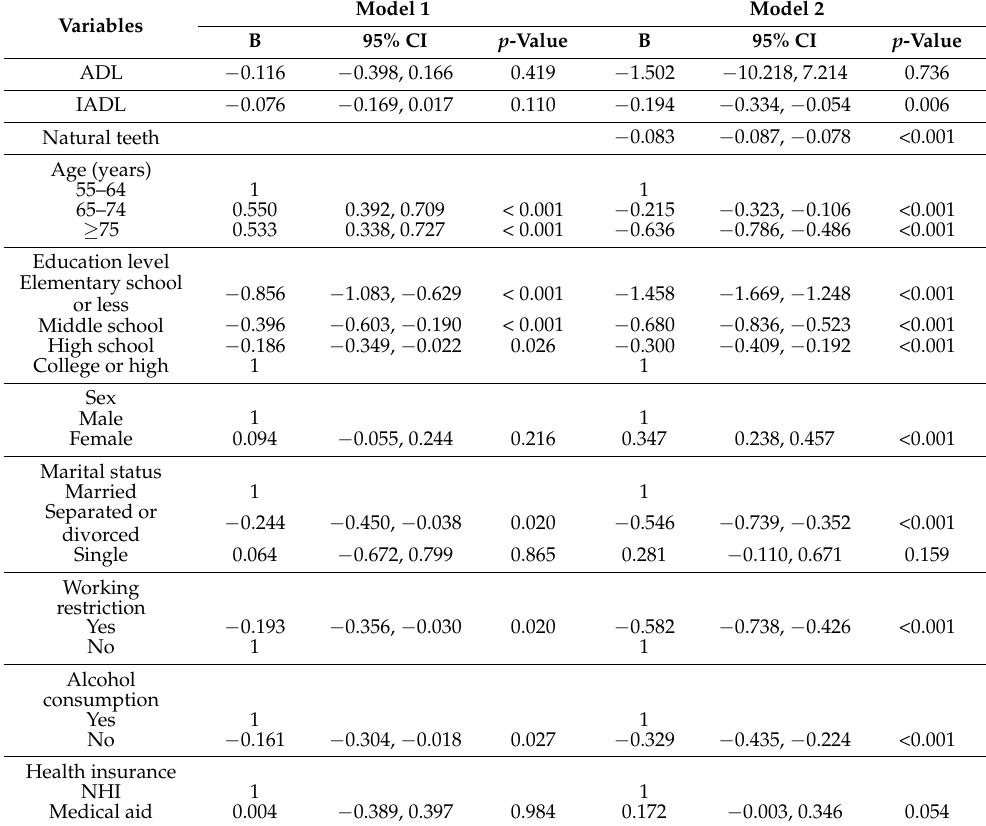
Table 3. Association between ADL/IADL and implant